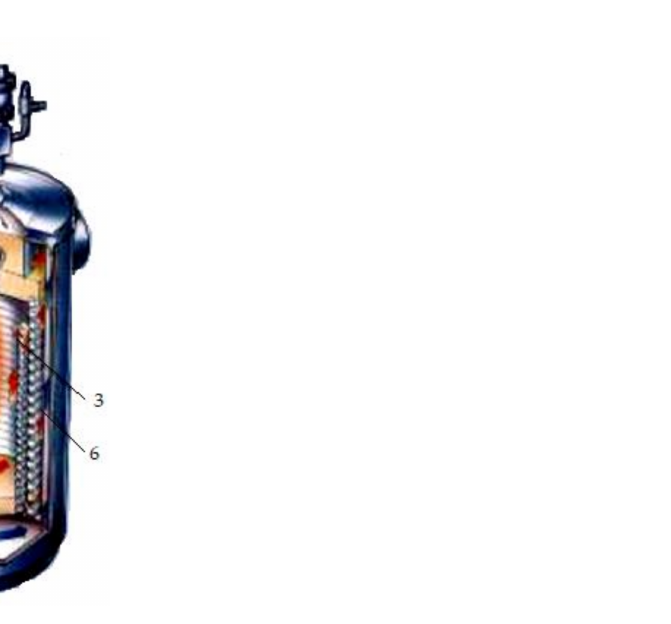
Figure 3. Direct-flow steam boiler device (appearance and cut of the boiler): 1—input camera,